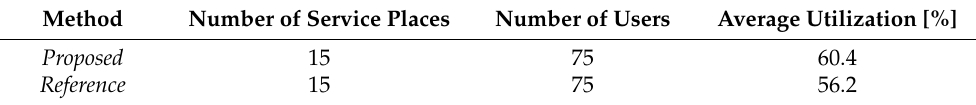
Table 3. A comparison of the average utilization of the service system for our method and reference method.